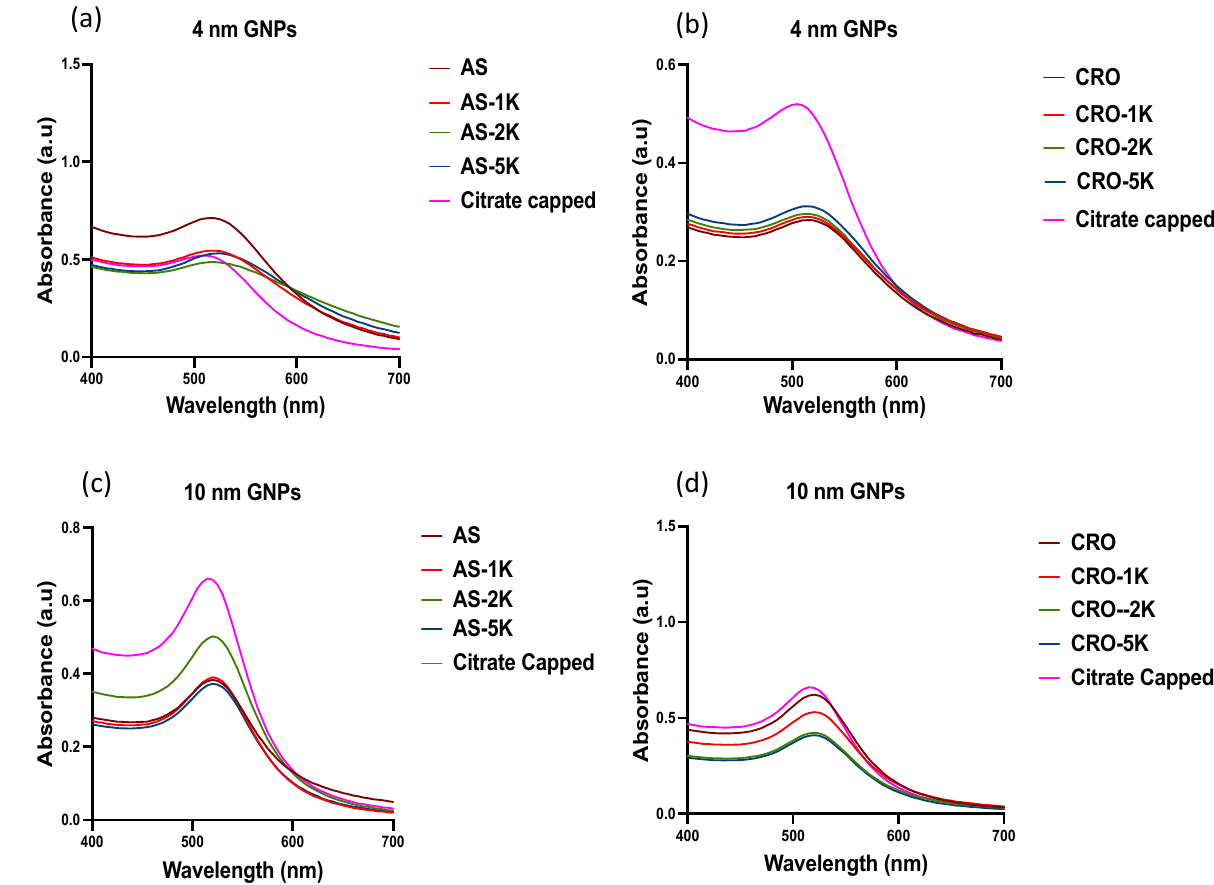
Figure 1. UV–vis spectra of GNPs; all particles conjugated with Gd. GNP formulations were denoted by the aptamer’s name CRO or AS (for AS1411) and PEG of different M w (denoted as 1K, 2K, and 5K in the graph for 1, 2, and 5 kDa PEG, respectively). ( a ) Citrate-capped, non-PEGylated, and PEGylated 4 nm GNPs conjugated with AS1411. ( b ) Citrate-capped, non-PEGylated, and PEGylated 4 nm GNPs conjugated with CRO. ( c ) Citrate-capped, non-PEGylated, and PEGylated 10 nm GNPs conjugated with AS1411. ( d ) Citrate-capped, non-PEGylated, and PEGylated 10 nm GNPs conjugated with CRO. The average hydrodynamic diameters of 4 and 10 nm citrate-capped GNPs dispersed in water were 4.8 ± 0.5 and 13.4 ± 1.2 nm, respectively. The average hydrodynamic diameters of the conjugated GNPs were measured in 1 × PBS and ranged from 11.1 to 25.9 nm and from 18.2 to 32.2 nm for 4 and 10 nm, respectively, Figure 2. These increases in size are consistent with previous research involving conjugation of AS1411 and CRO [14]. The particle sizes increased with increasing molecular weights of PEG. All GNPs were monodisperse with narrow size distribution and a PDI < 0.4. The citrate capping and other that ranged from − 22 to − 45 mV, implying that the applied coatings conferred stability oligonucleotides conjugated to the GNPs conferred upon them negative zeta ( ζ ) potentials